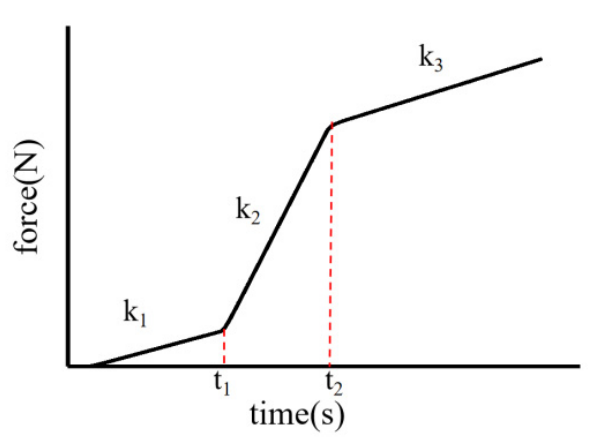
Figure 21. The variable slope pressure loading curve form.